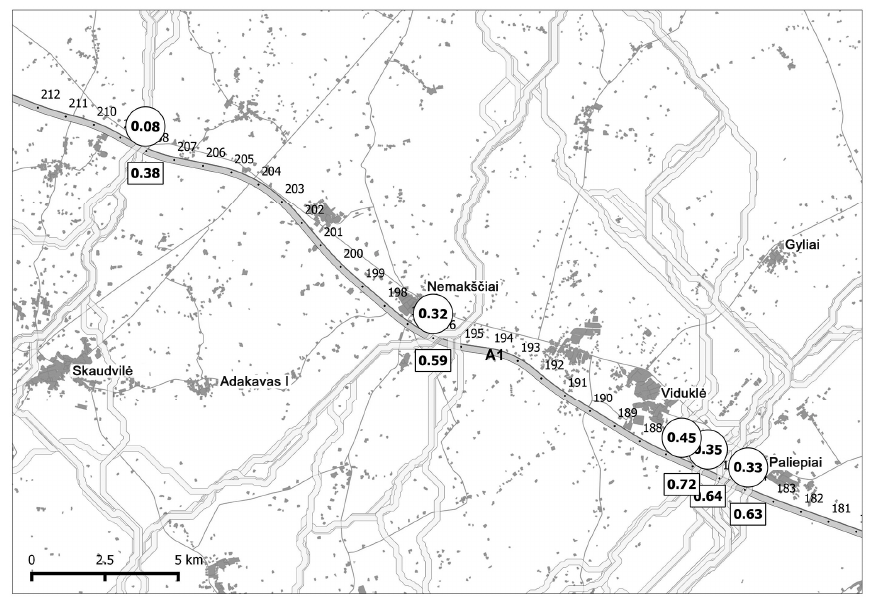
Figure 6. Example of model output for highway A1. Grey lines represent simulated paths. Numbers in circles above highway represent segment ranks based on conditions within a 1 km buffer on both sides of the highway. Numbers below (in rectangles) represent segment ranks based on the full pathway statistics. Numbers from 182 to 212 represent sequential 1 km long highway segments. Map was created in QGIS version 2.8 “Wien” (http://www.qgis.org/), licensed under the GNU General Public License, using background data from the Lithuanian Asset Information System (http://lakis.lakd.lt/lakis/).